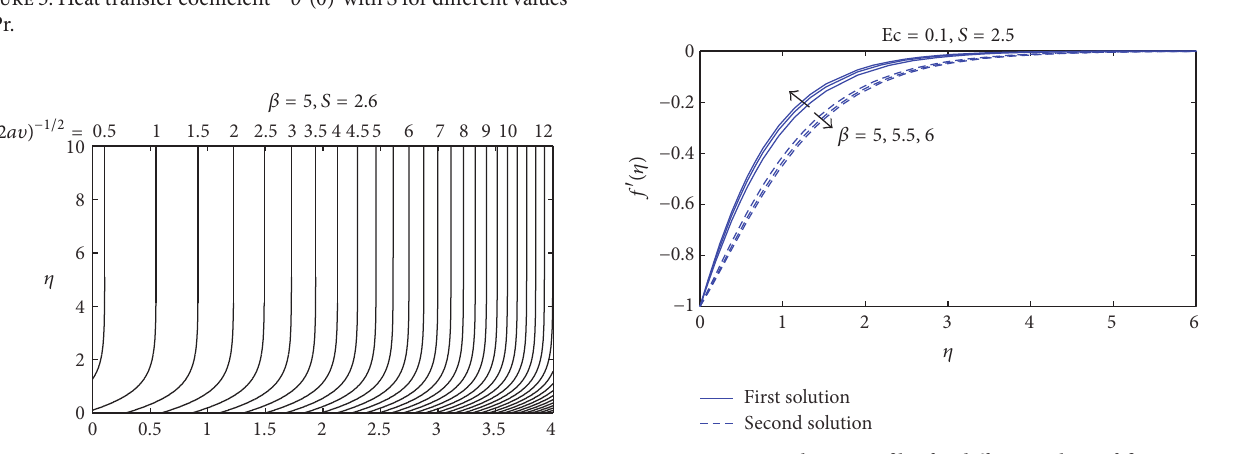
Figure 8: Velocity profiles for different values of 𝛽